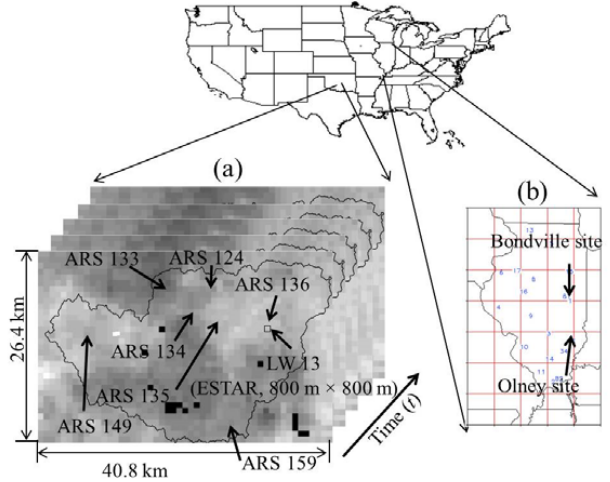
Figure 2. Study sites ( a ) Little Washita (LW) watershed in Oklahoma; and ( b ) Bondville (BOND) and Olney (OLN) sites in